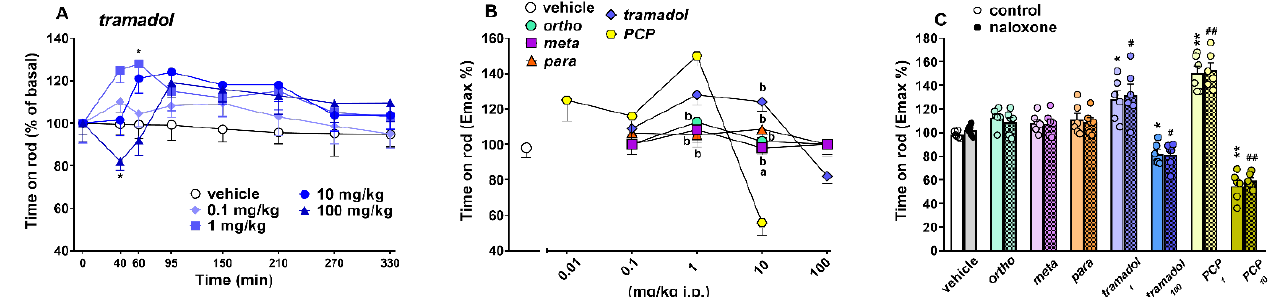
Figure 9. Effect of the systemic administration of tramadol (0.1–100 mg/kg i.p.; ( A ) on the accelerod test in mice. Comparison of the maximal effect of ortho, meta, para, tramadol (0.1–100 mg/kg) and PCP (0.01–10 mg/kg) observed in 5 h ( B ) 1,2 . Interaction of the maximal effective doses of ortho, meta, para (100 mg/kg), tramadol (1 and 100 mg/kg) and PCP (1 and 10 mg/kg) with the opioid receptor antagonist naloxone (6 mg/kg, i.p.; ( C )). Data are expressed as percentage of basal and represent the mean ± SEM of 6–8 determinations for each treatment. Statistical analysis was performed by two-way ANOVA, followed by the Bonferroni test for multiple comparisons for the dose–response curve of each compound at different times ( A ), and for the antagonist studies ( C ), while the statistical analysis of ( B ) was performed with one-way ANOVA followed by Bonferroni test for multiple comparisons. * p < 0.05, ** p < 0.01, versus vehicle; a p < 0.05 versus tramadol; b p < 0.05 versus PCP; # p < 0.05, ## p <0.01 versus naloxone; 1 ortho, meta and para data are elaborated from [5]; 2 PCP data are elaborated from [17].